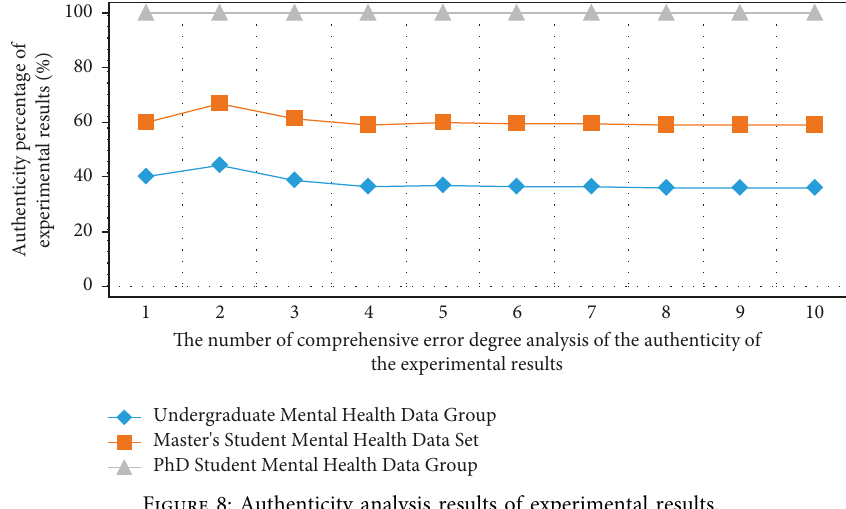
Figure 8: Authenticity analysis results of experimental